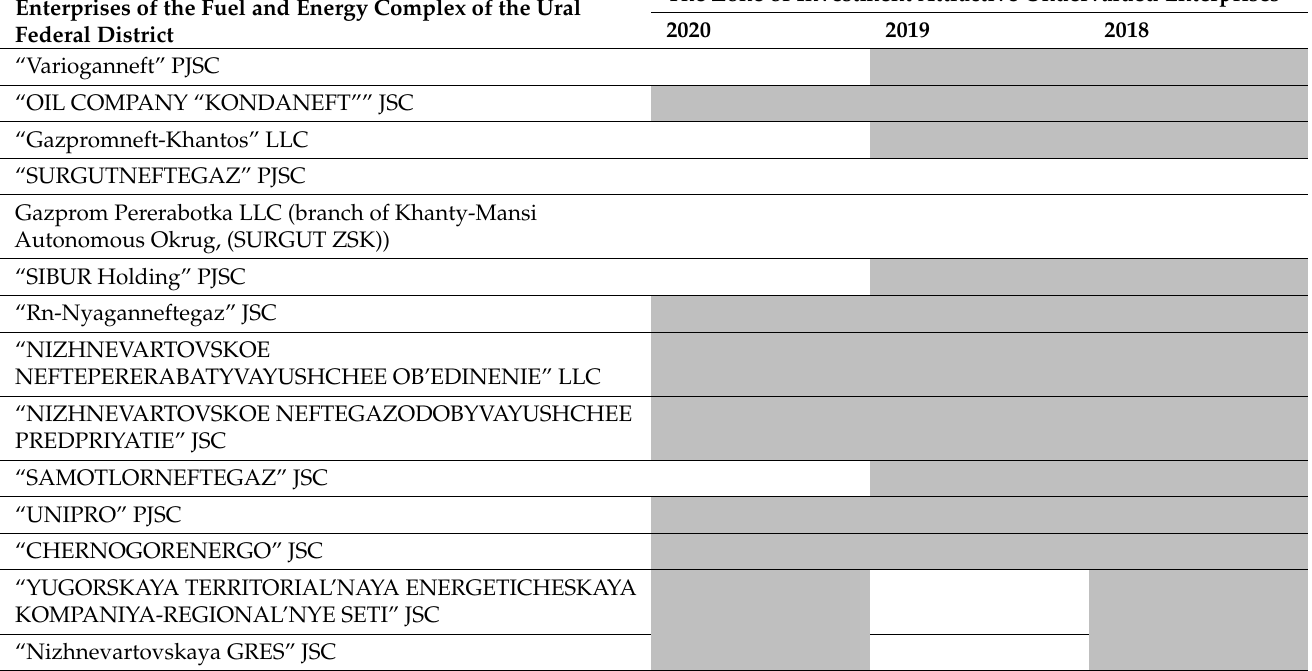
Table 2. Measurement of the investment attractiveness of enterprises in the industrial complex of the fuel and energy complex of the Ural Federal District based on the assessment of the EVA/EBITDA multiplier (table